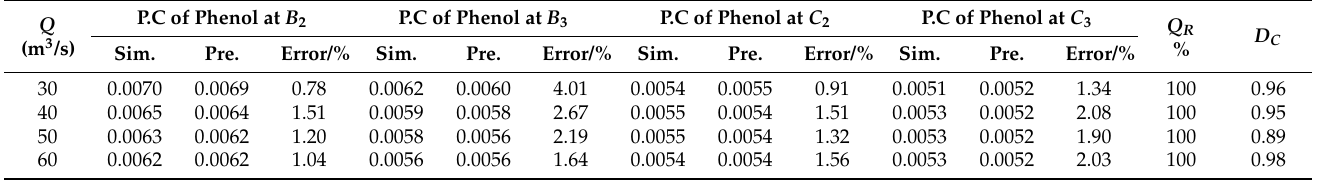
Table 7. The results of the rapid prediction of phenol in the L-B section and J-D